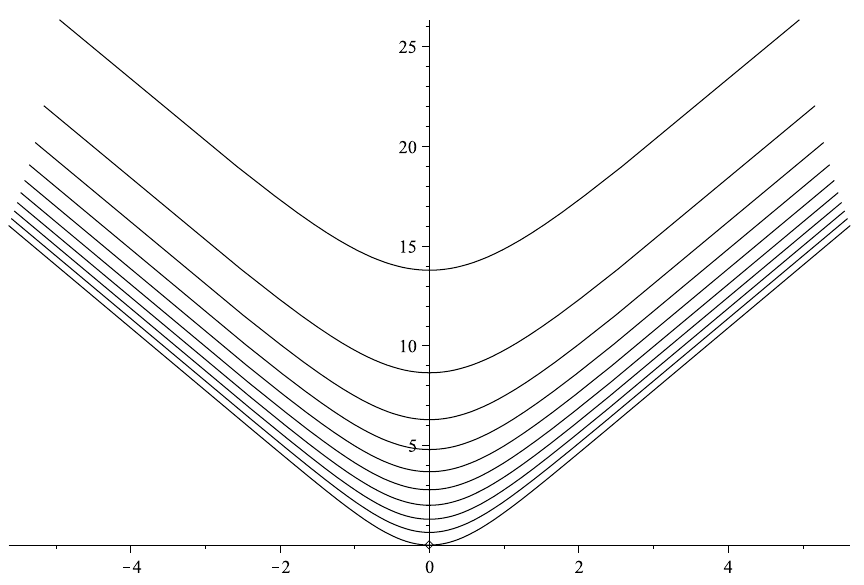
Figure 24 . Volume (cid:1) V=r H of maximal slice vs Schwarzschild time r H t 1 for T = k= 10, k = 0 :: 9 from bottom to